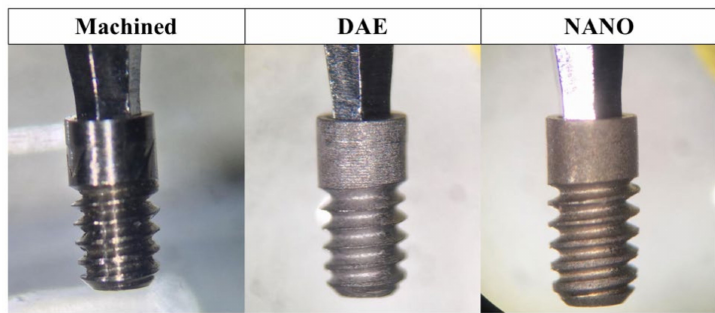
Figure 2. Macrogeometry of machined, DAE, and NANO implants used in the